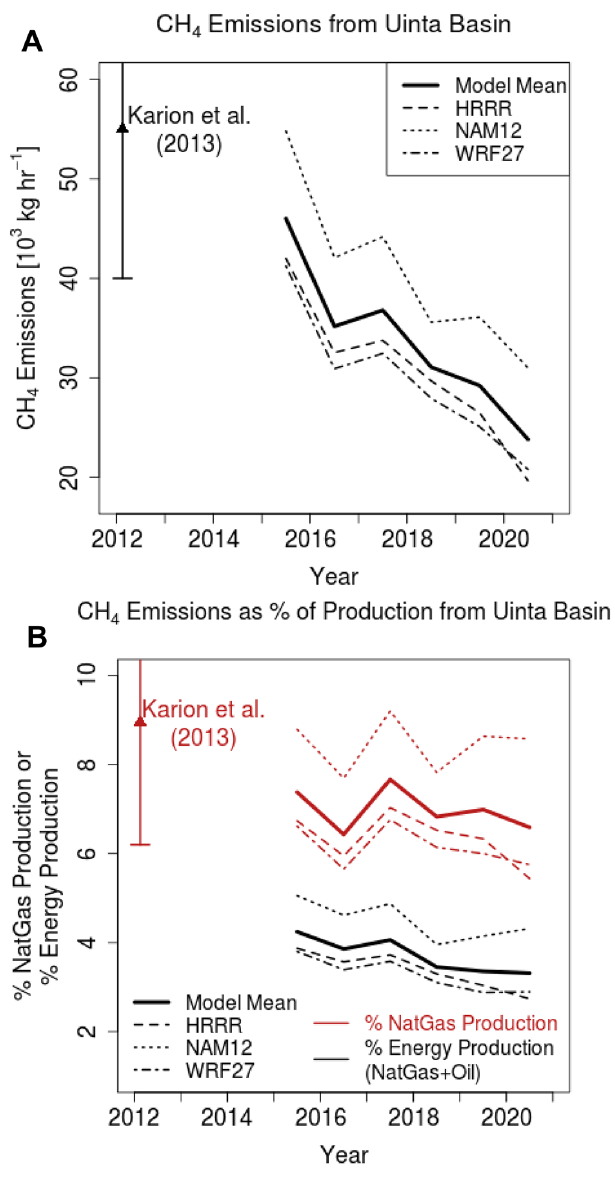
Figure 3. Annual CH 4 emissions from the Uinta Basin. ( A ) Multi-year CH 4 emissions calculated from CH 4 enhancements observed at the HPL site (Fig. 2B) and atmospheric modeling (Eq. (1) in “Methods”). Multiple meteorological fields used to drive the STILT model are indicated by the three different dashed lines. The thick solid line is an average of results calculated from the three meteorological fields. Results based on Feb 2012 aircraft mass balance analyses from Karion et al. 26 are also shown, with error bars (1- σ ). ( B ) Multi-year CH 4 emissions shown as percentage of the natural gas produced from the Uinta Basin (red) or as percentage of the total energy produced (black; including both natural gas and oil). Dashed lines and thick solid line, similar to (A), again refer to results from different meteorological fields and the multi-model average,